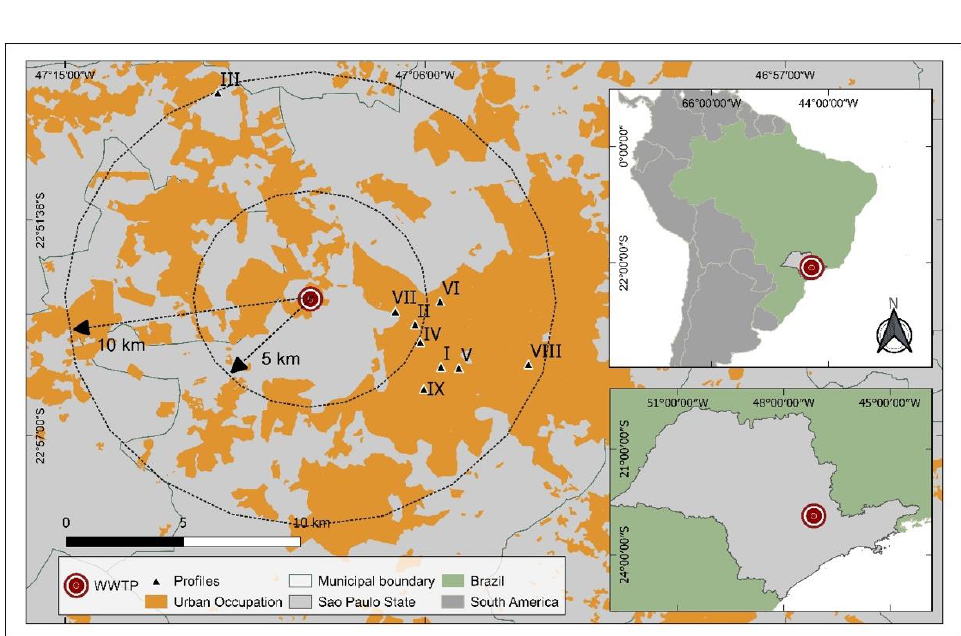
Figure 2. Industrial profiles surrounding the WWTP.